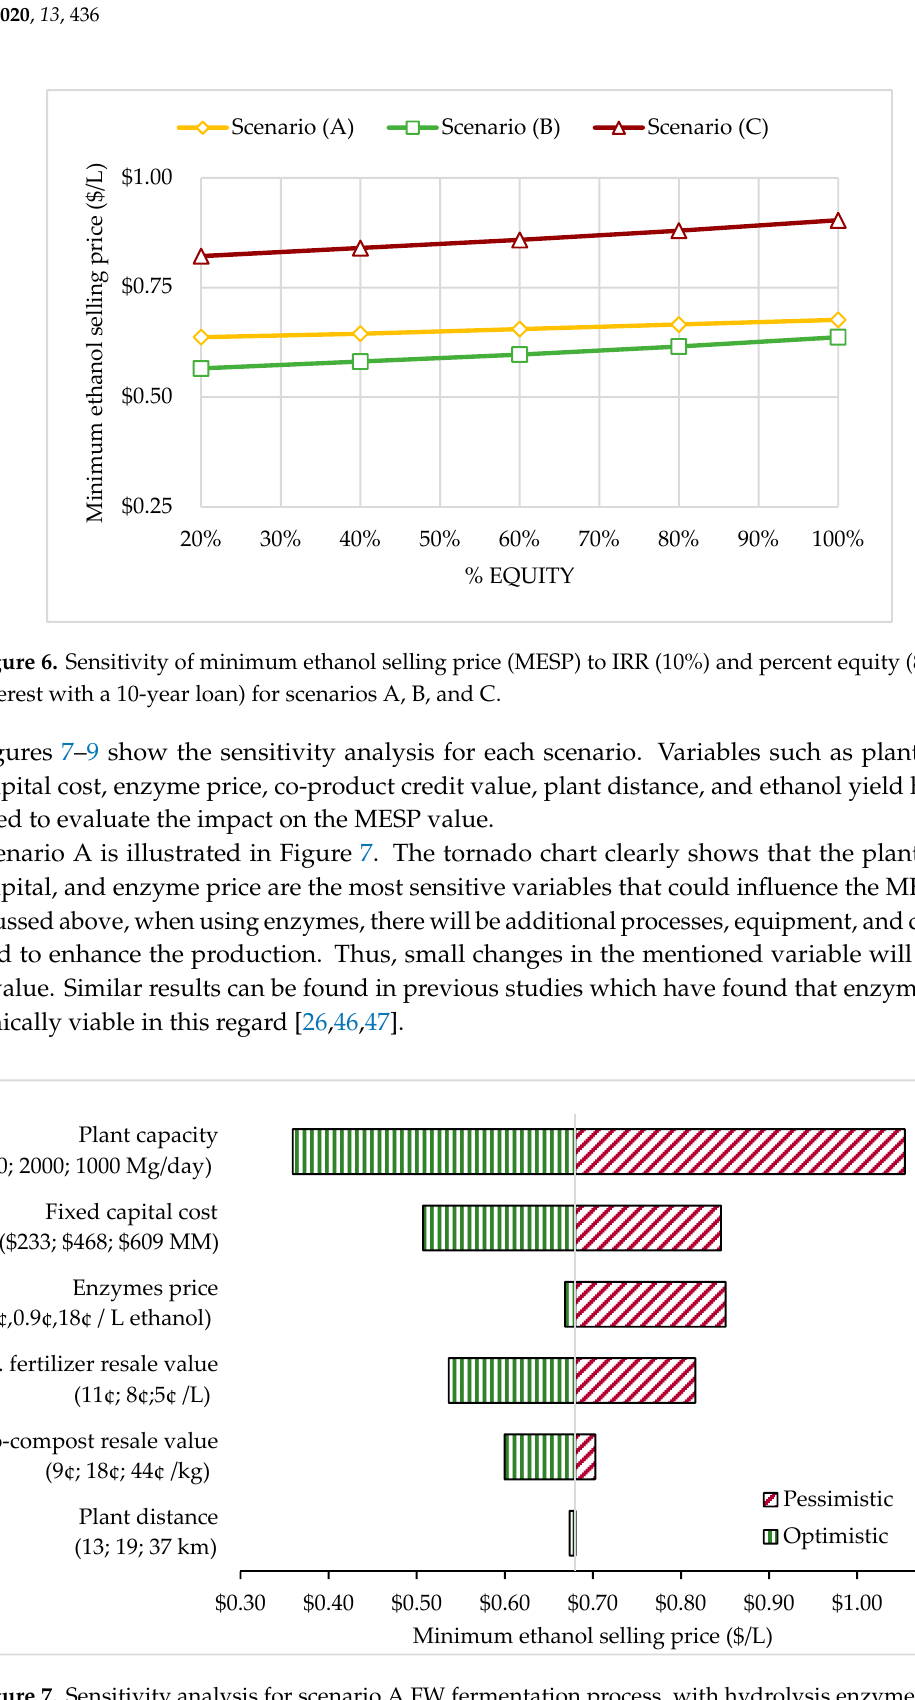
Figure 7. Sensitivity analysis for scenario A FW fermentation process, with hydrolysis enzymes and a 2-step distillation system. Optimistic is the best-case scenario simulation and pessimistic is the worst-case scenario simulation.